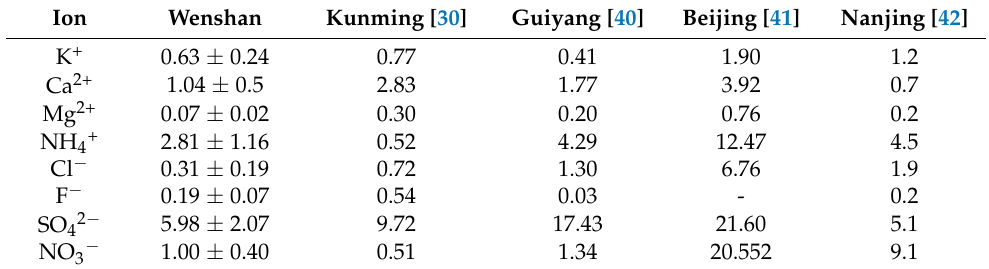
Table 1. Mean concentrations of WSIIs sampled in Wenshan in 2016 compared with data from other sites ( µ g/m 3 ).